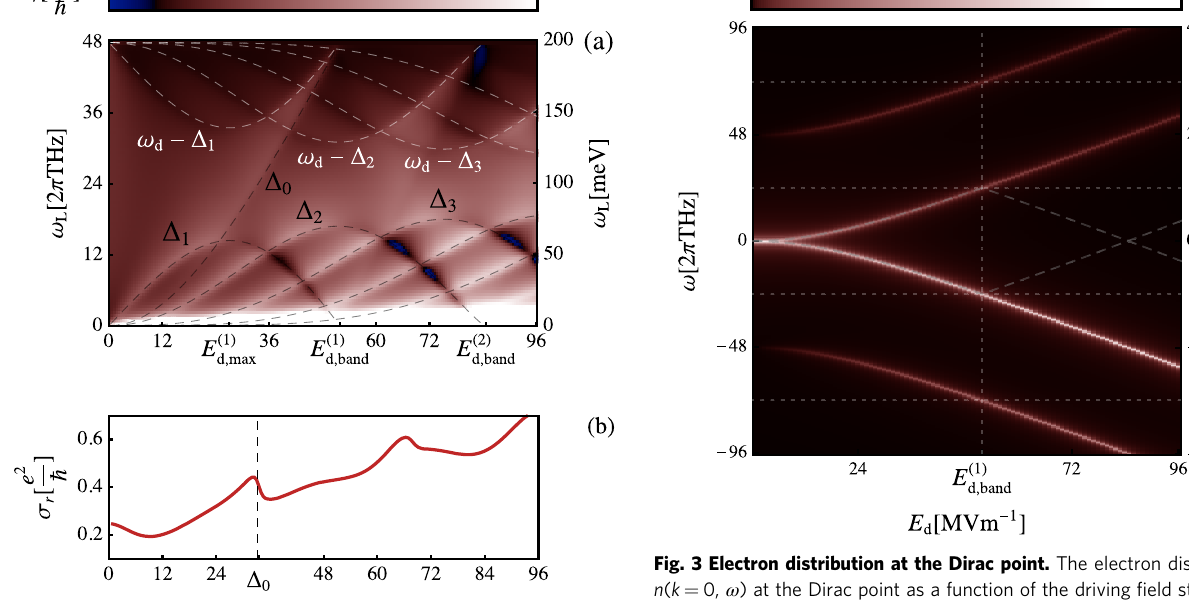
d . ffiffiffiffiffiffiffiffiffiffiffiffiffiffiffiffiffiffiffiffiffiffiffiffiffiffiffiffiffiffiffiffiffi q v 2 E 2 = ω 2 = 4 ¼ 2 þ ω 2 (cid:2) ω , 0 d d F d d